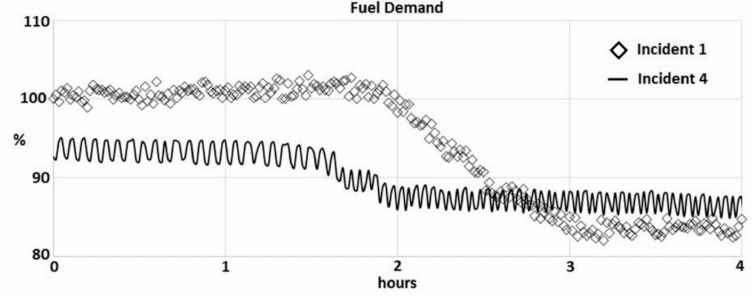
Figure 15. Normalised GGT inlet temperature during Incidents 1 and 4.